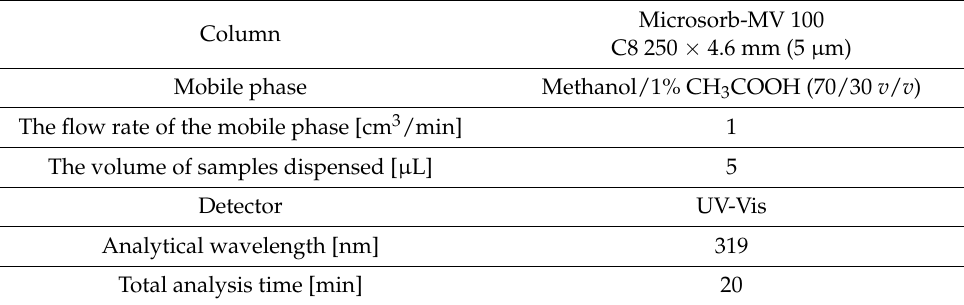
Table 4. Chromatographic analysis